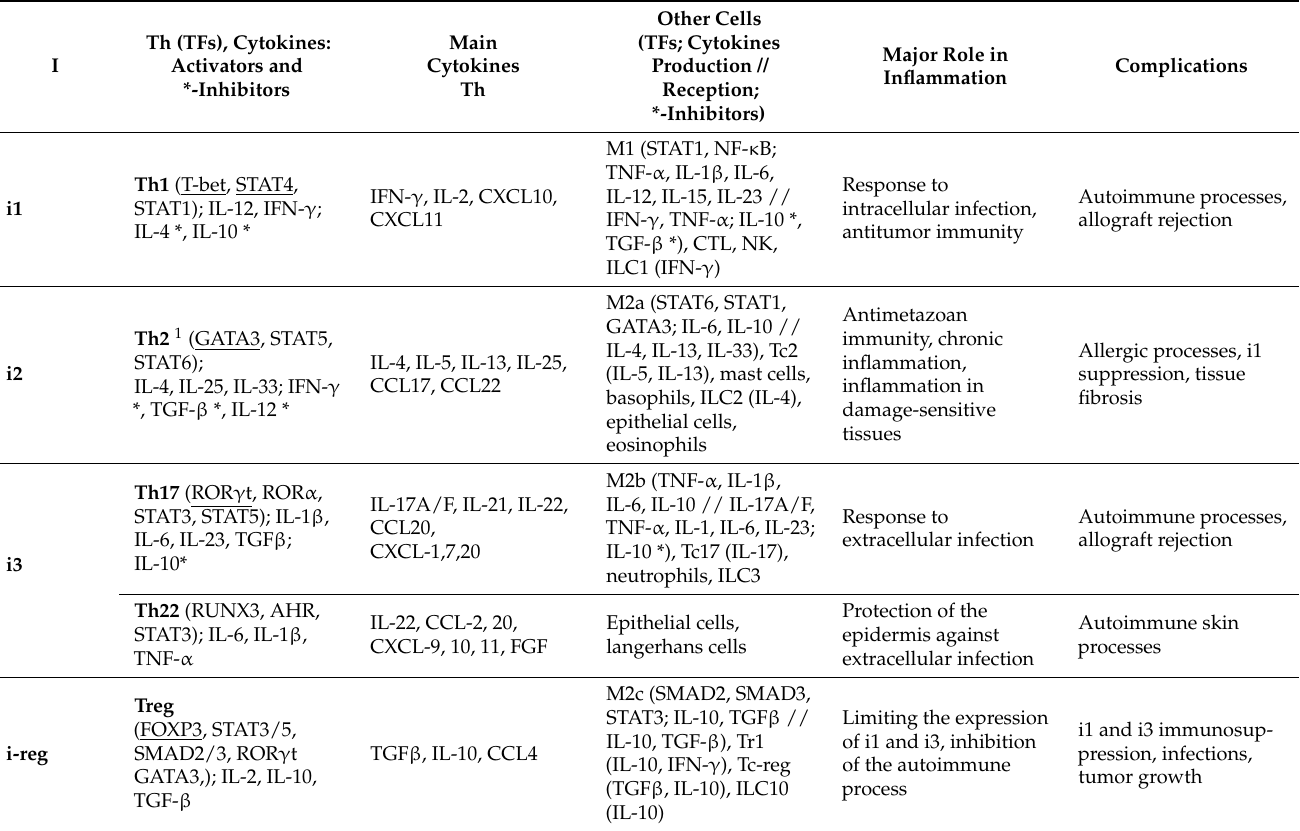
Table 2. Vectors of immune response (I)